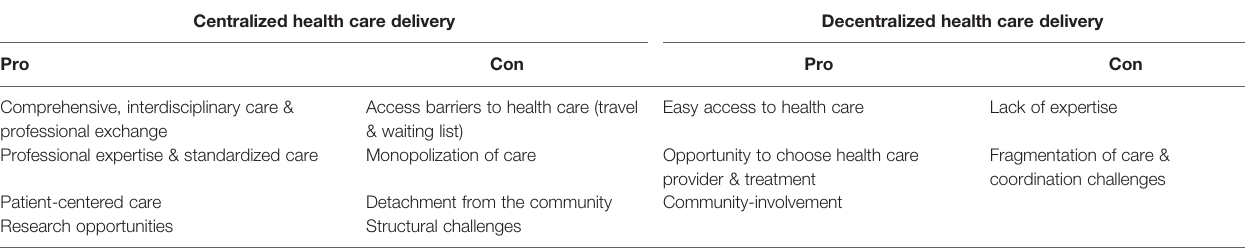
TABLE 3 | Pros and Cons of (de-)centralized transgender health care